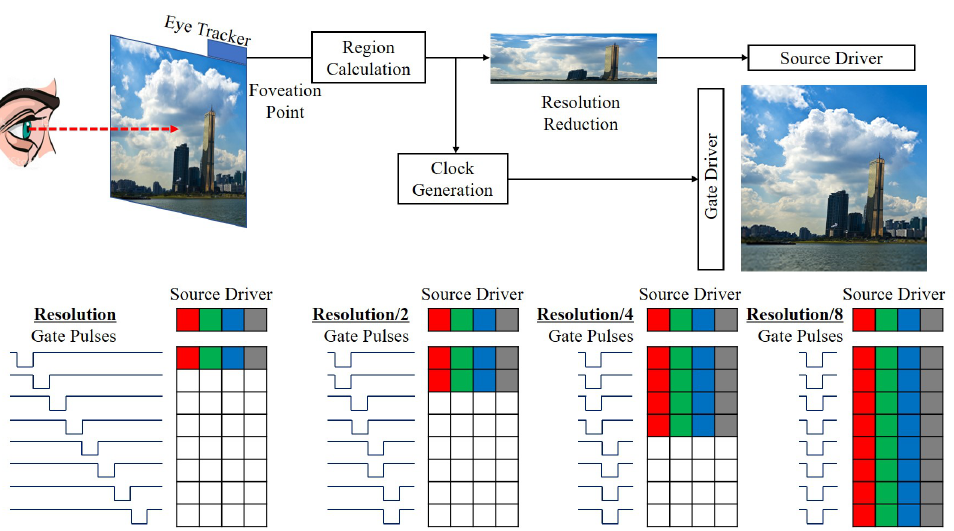
Figure 1. Previous foveation-based driving scheme. The vertical resolution of the input image is reduced according to f RR and transferred to source drivers. Then, these reduced image is restored to the foveated image with the original resolution in a panel by multi-output gate driver circuits. When driving the panel, one line is updated at a time for the original resolution, two lines for the 1/2 resolution, four lines for the 1/4 resolution and eight lines for the 1/8